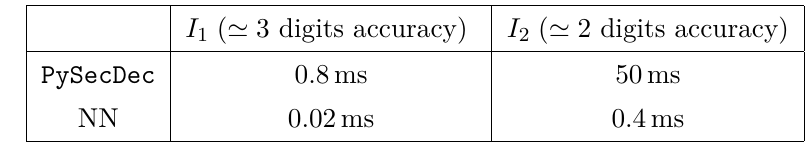
Figure 4 . Distribution of the logarithm of the ratio between the estimate and the true value of the integral for different values of cornerness. The data is for integral I 1 and the tanh activation function.